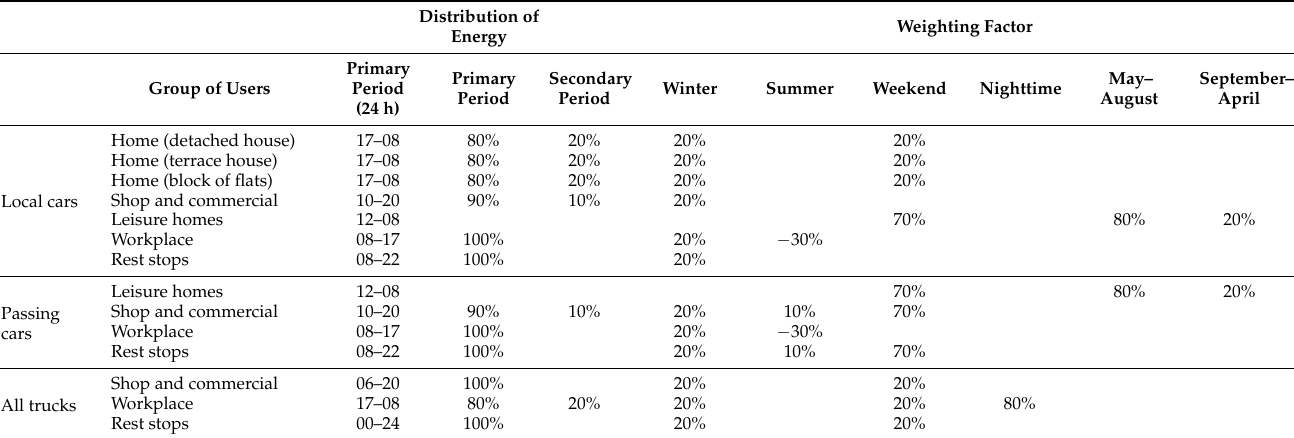
Table 5. Parameters used to divide the additional energy according to the hours of the day and months of the